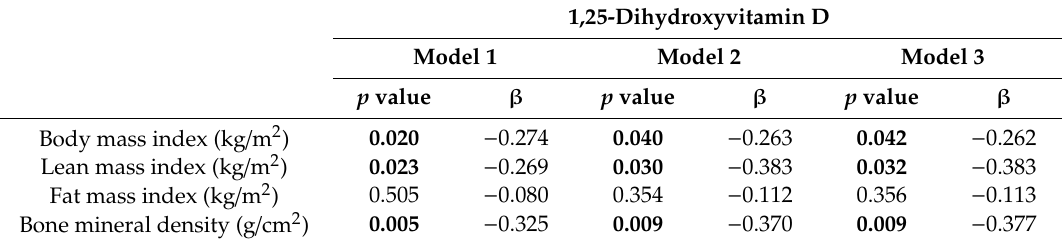
Figure 1. Simple linear regression graphs between 1,25-Dihydroxyvitamin D (1,25(OH) 2 D) and body mass index (BMI) ( A ), lean mass index (LMI) ( B ), fat mass index (FMI) ( C ), and bone mineral density (BMD) ( D ) in middle-aged sedentary adults. β (standardized regression coefficient), R 2 , and P from a simple linear regression analysis. Table 2. Association of 1,25-Dihydroxyvitamin D with body mass index, lean mass index, fat mass index and bone mineral density.